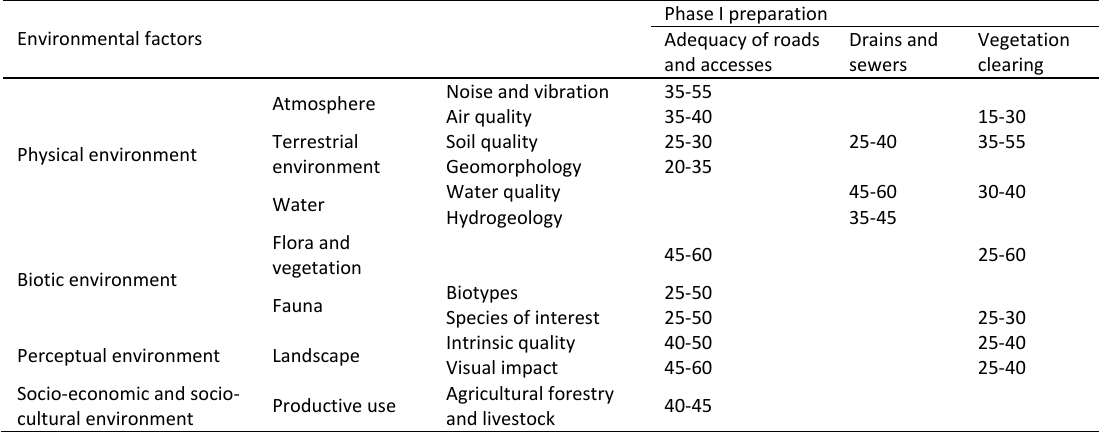
Table 4: Importance of the most significant environmental impacts in ornamental rock and aggregate quarries in the Region of Murcia in Phase I of preparation